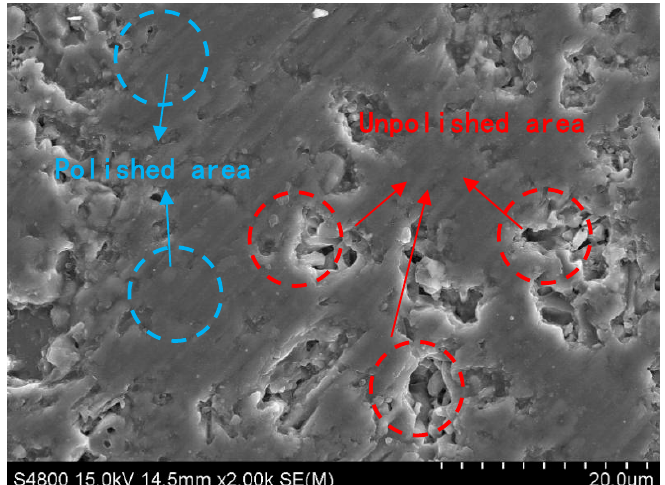
Figure 9. Micromorphology of 90# calcined bauxite surface ( × 500): ( a ) before the polishing process; ( b ) after the polishing process.